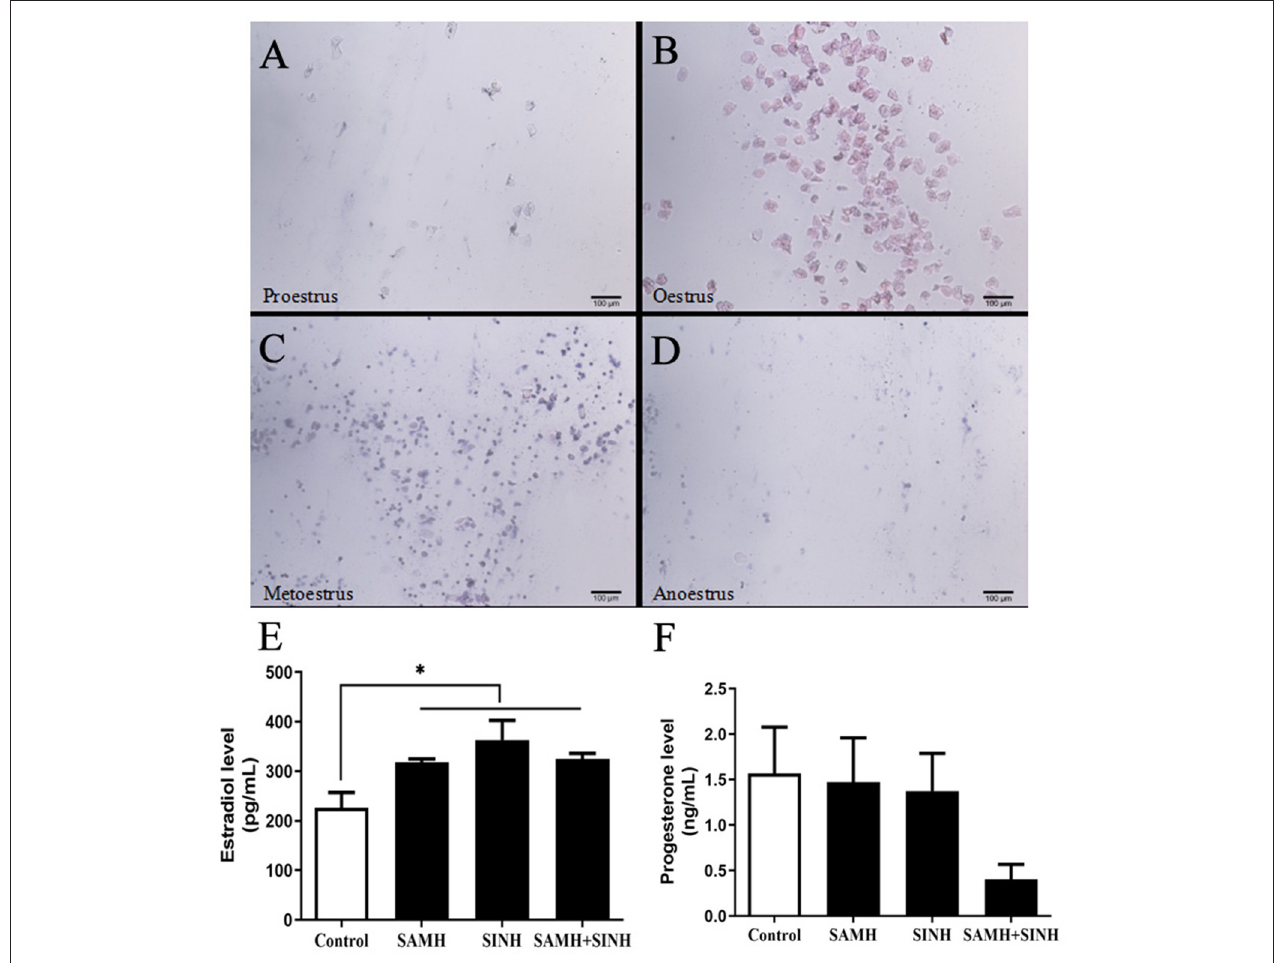
FIGURE 5 | Effects of inhibin (INH) and AMH plasmids co-immunization on levels of estradiol and progesterone. (A–D) Vaginal smears of mice at the stages of the estrous cycle, the scale bar represents 100 µ m. (E,F) Changes in steroid hormone of mice in estrus at week 4 after the primary immunization. Data are expressed as mean ± SEM, * p < 0.05 between the indicated experimental conditions.